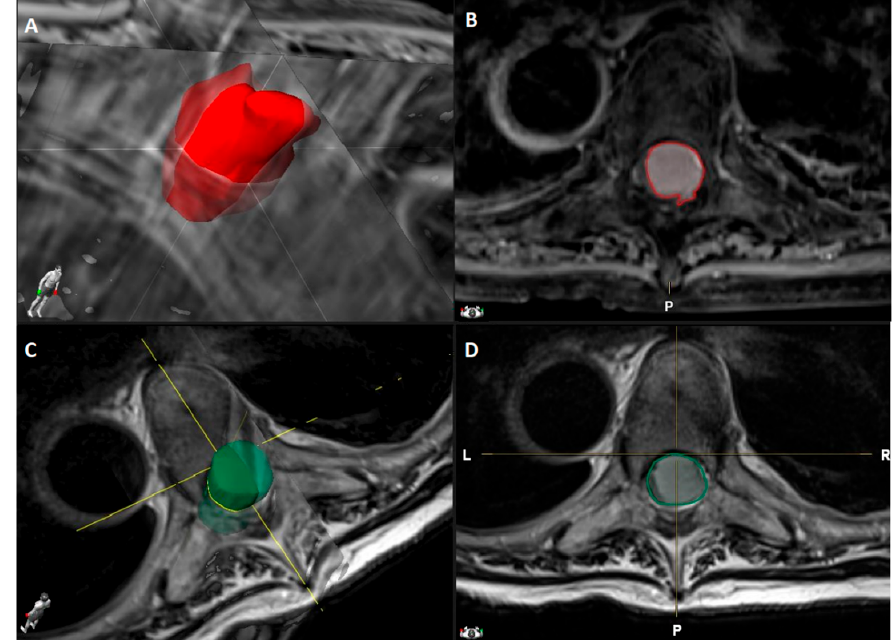
Figure 1. Dorsal Th5-Th6 WHO grade I meningioma with anterior dural attachment: ( A ) 3D tumor volume rendering (2.6 cm 3 ) obtained by ( B ) tumor segmentation on axial T1-weighted MRI images after contrast administration using Brainlab Elements ® ; ( C ) Spinal canal volume rendering (3.5 cm 3 ) obtained by ( D ) spinal canal segmentation on axial T2-weighted MRI images using Brainlab Elements ® .